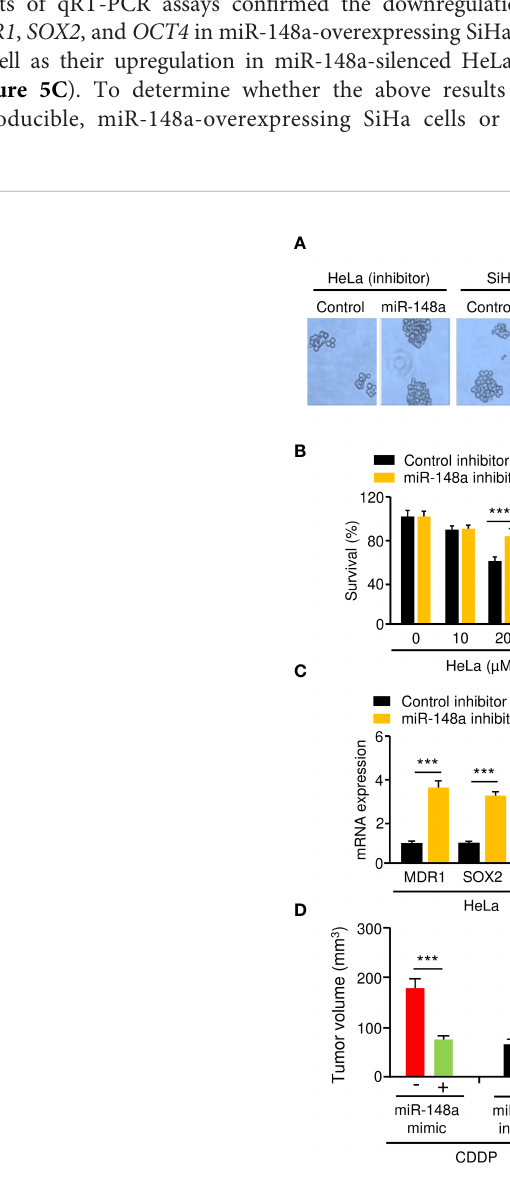
FIGURE 5 | MiR-148a Inhibits Sphere Formation and CDDP resistance in CC Cells. (A) The effect of miR-148a expression on the sphere formation was investigated using sphere formation assays. (B) After transfection with miR-148a mimic or miR-148a inhibitor, CC cells were treated with CDDP and cell viability was measured using cell viability assay. (C) The qRT-PCR analysis of MDR1 , SOX2 , and OCT4 expression in CC cells transfected as indicated. (D) MiR-148a overexpression (or knockdown) increased (or decreased) the sensitivity of CC cells to CDDP in vivo . *** P <